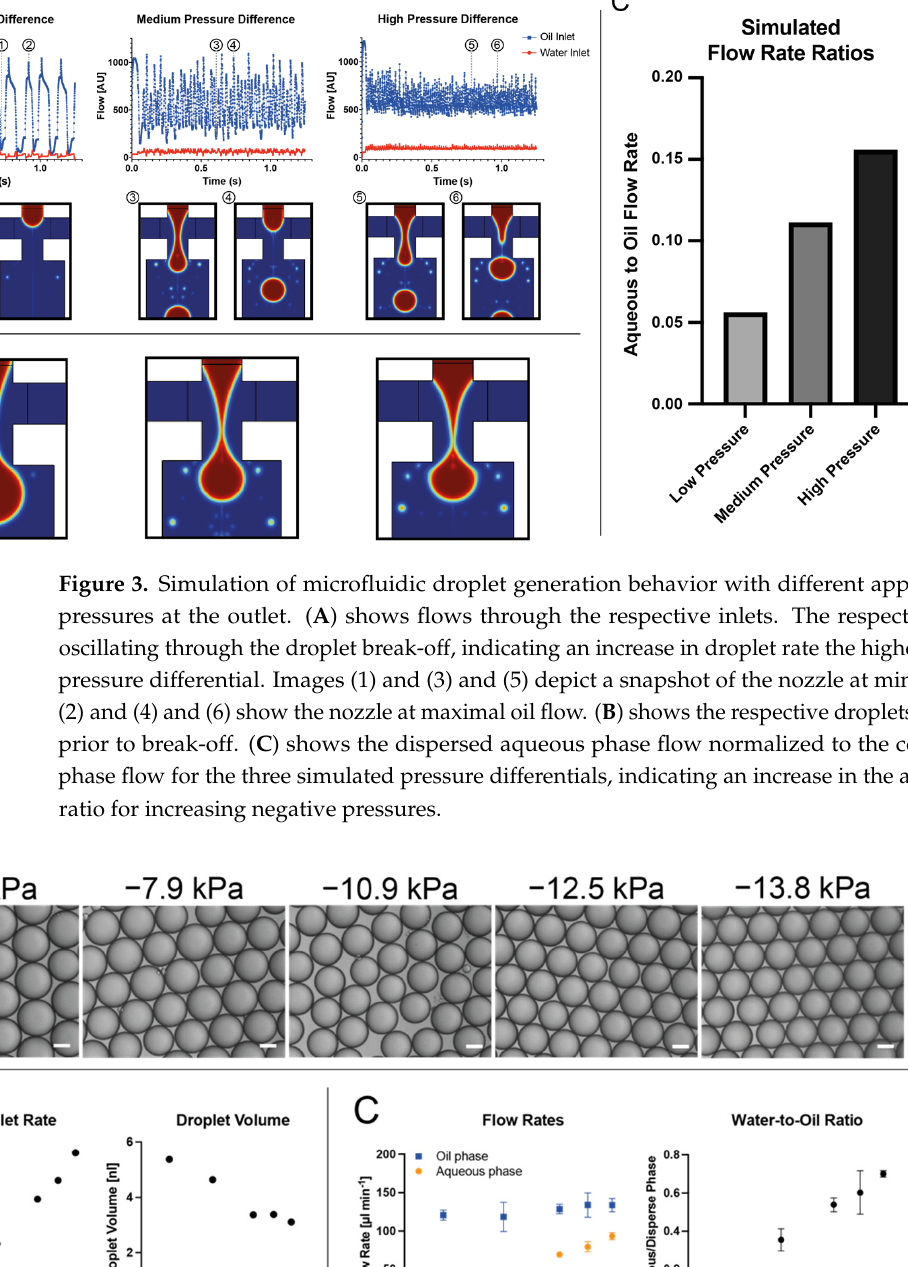
Figure 3. Simulation of microfluidic droplet generation behavior with different applied negative pressures at the outlet. ( A ) shows flows through the respective inlets. The respective flows are os- cillating through the droplet break-off, indicating an increase in droplet rate the higher the applied pressure differential. Images (1) and (3) and (5) depict a snapshot of the nozzle at minimal oil flow, (2) and (4) and (6) show the nozzle at maximal oil flow. ( B ) shows the respective droplets immedi- ately prior to break-off. ( C ) shows the dispersed aqueous phase flow normalized to the continuous oil phase flow for the three simulated pressure differentials, indicating an increase in the aqueous- to-oil ratio for increasing negative pressures.